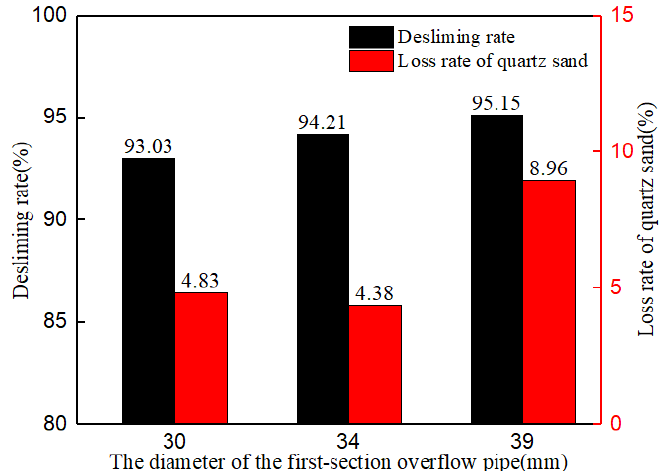
Figure 10. Influence of the first-section overflow pipe diameter on the desliming performance.